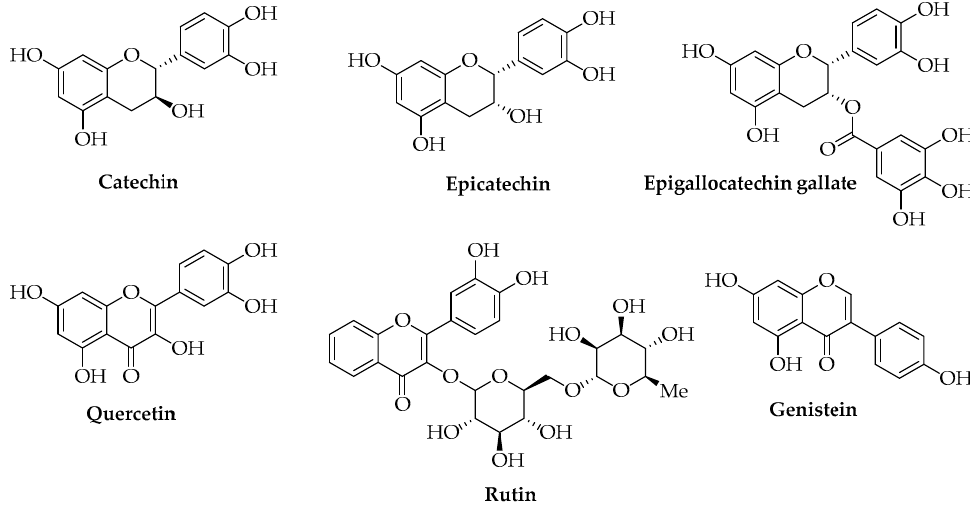
Figure 5. Chemical structures of the most common